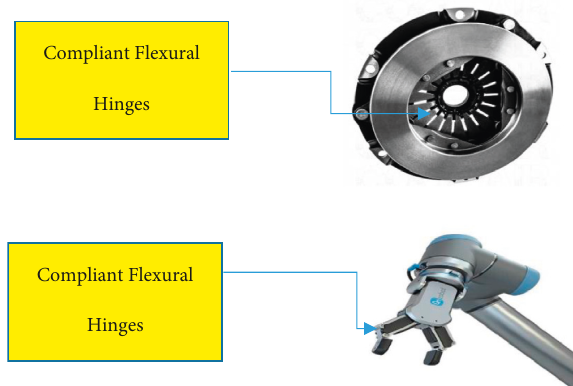
Figure 1: Flexural design in compliant mechanisms —for mech- anisms in robotics.